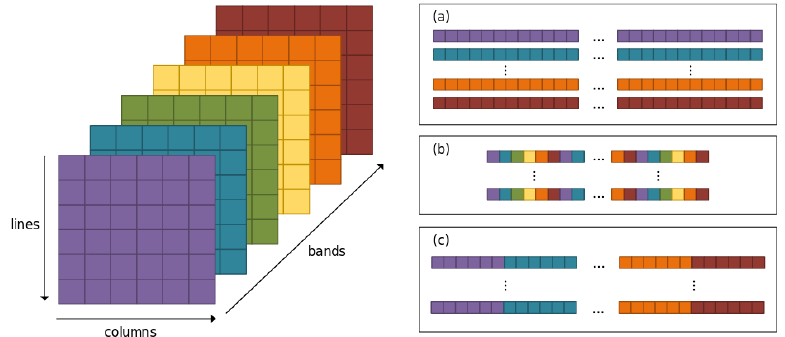
Figure 2. Samples arrangements: ( a ) Band-Sequential (BSQ); ( b ) Band-Interleaved-by-Pixel (BIP); ( c ) Band-Interleaved-by-Line